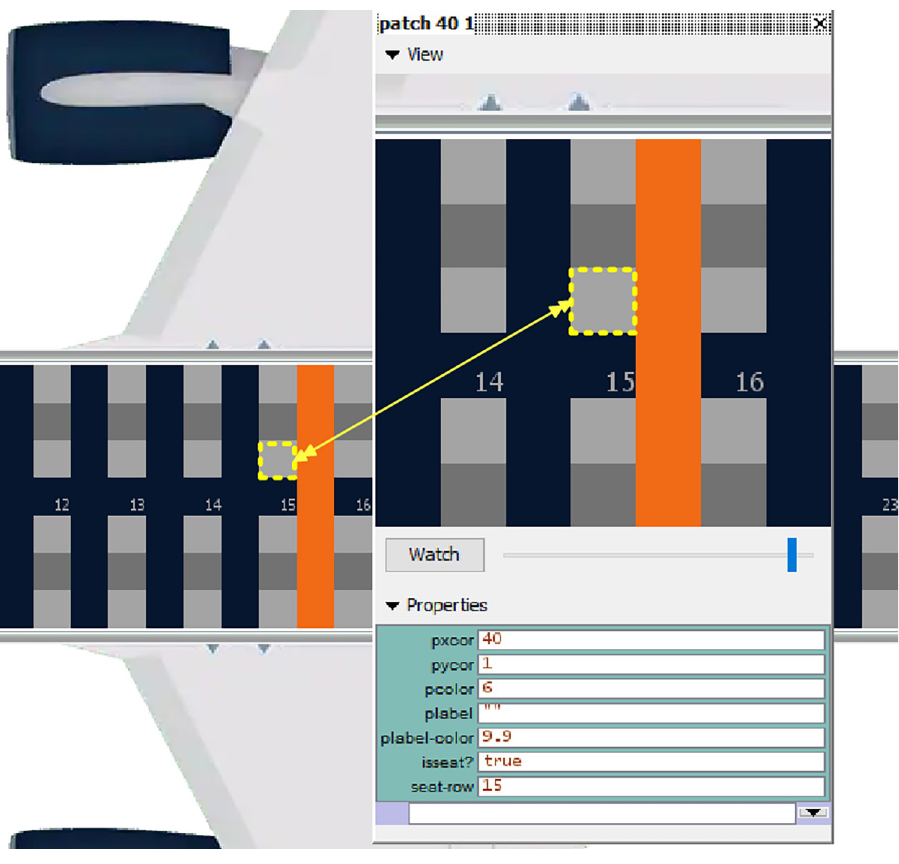
Fig 9. Example of a patch